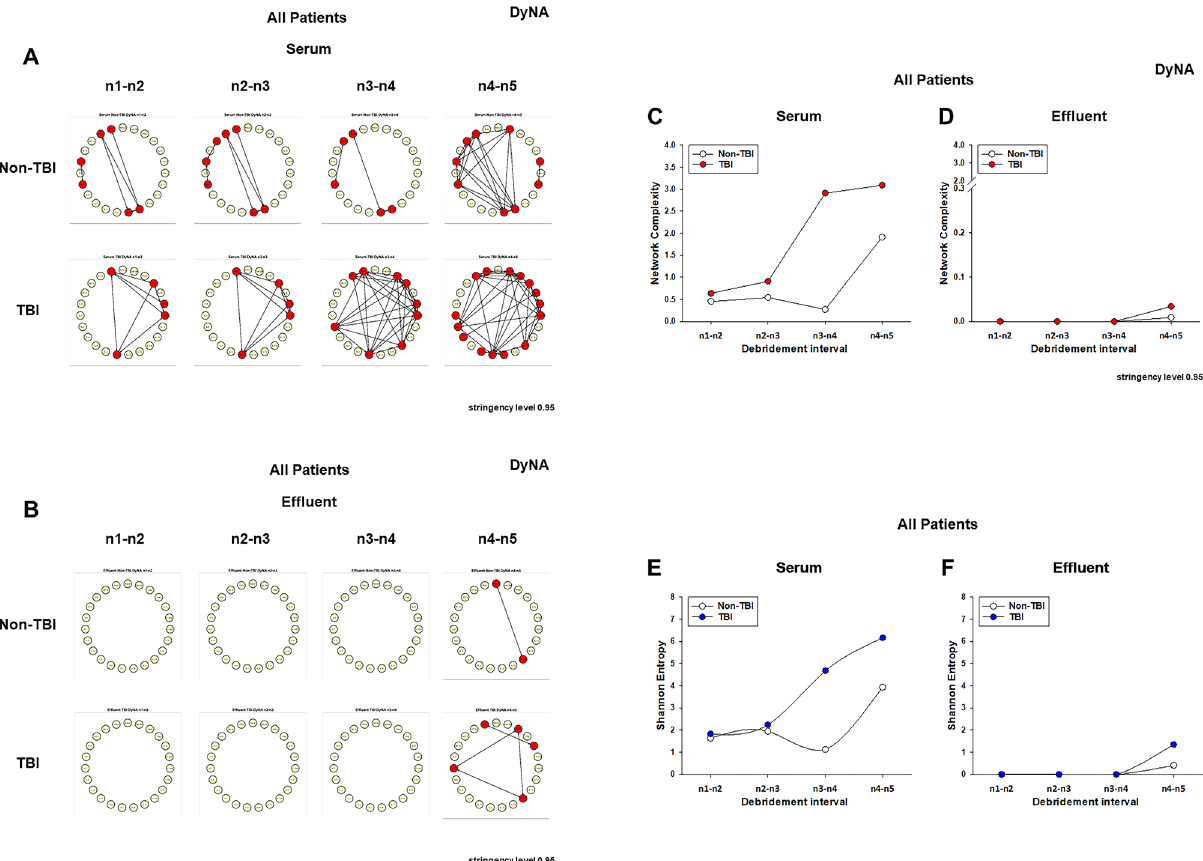
Figure 2. Differential dynamic inflammatory networks in TBI vs. non-TBI trauma patients. Circulating inflammatory mediators in serum samples from 59 TBI and 81 non-TBI patients were measured, and DyNA (stringency level = 0.95) was performed during each of four debridement intervals (n1-n2, n2-n3, n3-n4, n4-n5) using MATLAB® software as described in “Materials and methods”. ( A , B ) Show an overview of all the networks and mediator connections in both patient subgroups in ( A ) serum and ( B ) effluent (the closed circles represent mediators with at least one connection to another mediator, while open circles represent mediators that had no connections to other mediators as determined by DyNA). ( C (serum), D (effluent)) Shows the network complexity for each patient subgroup during each of the four debridement intervals calculated as described in “Materials and methods”. ( E (serum), F (effluent)) Shows the Shannon Entropy for each network calculated as described in “Materials and